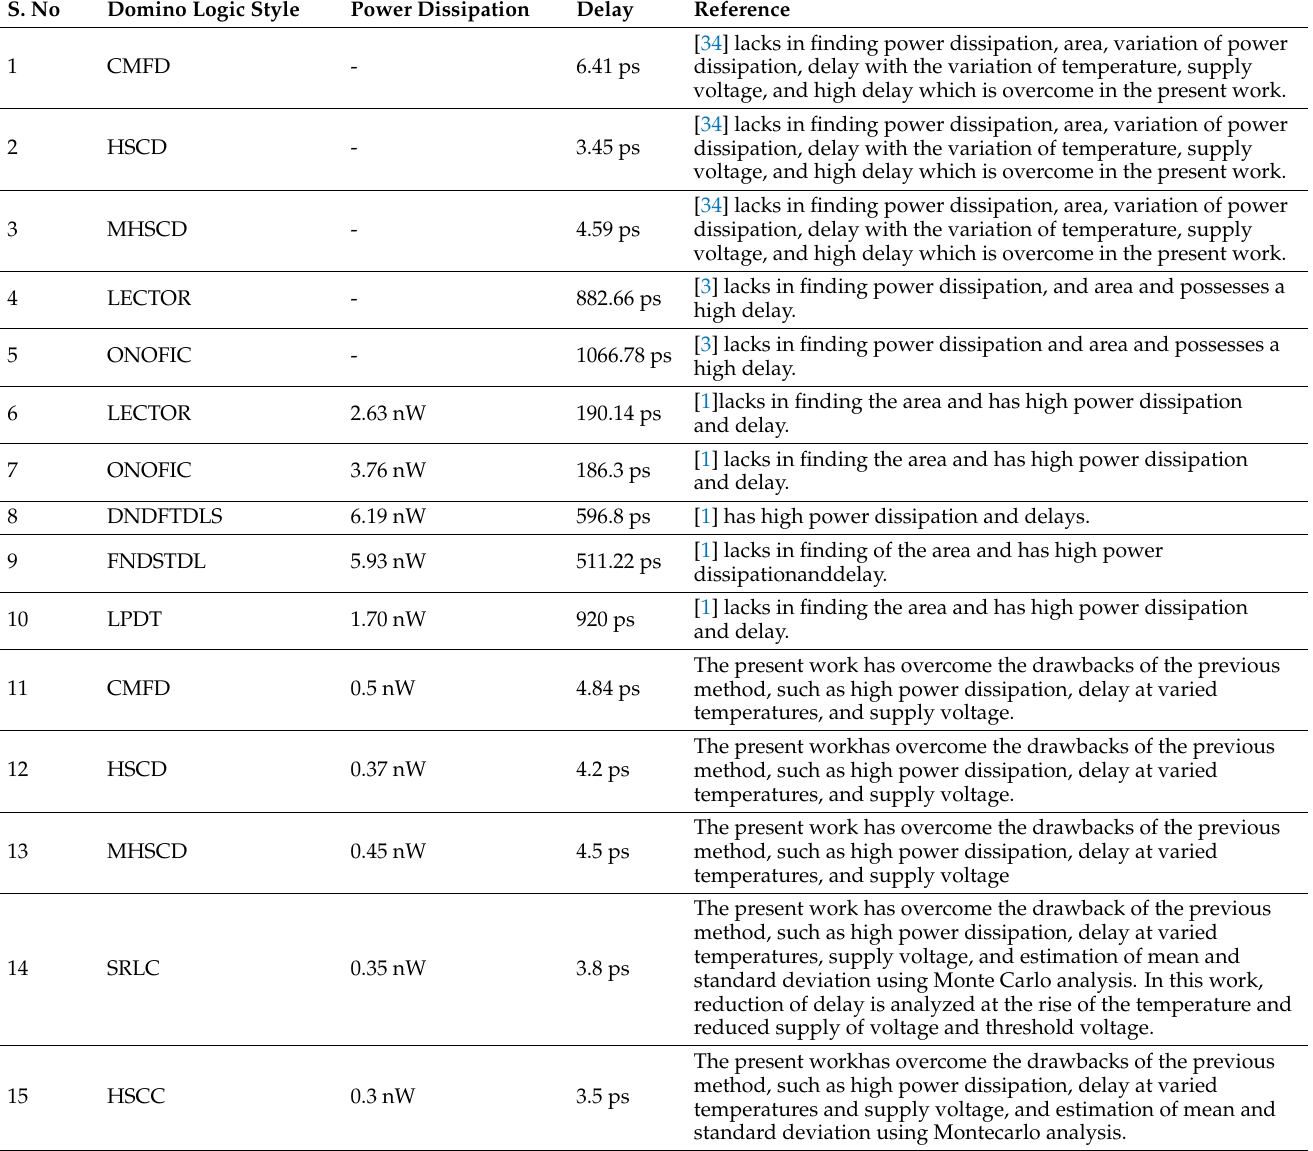
Table 4. Comparison of various FinFET domino logic styles at 7 nm technology